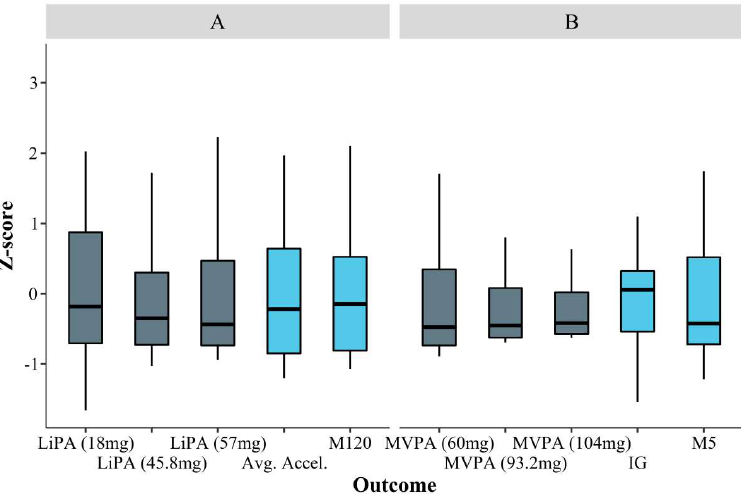
Figure 1. Box plots representing the distribution of Z-values for the conventional (grey) and cut-point-free (blue) physical activity accelerometer metrics, corresponding to: ( A ) physical activity volume and ( B ) intensity. LiPA = Light-intensity physical activity; Avg.Accel. = Average accelera- tion; M120 = Acceleration above which the most active 120 min of the day are accumulated. MVPA = Moderate-to-vigorous physical activity; IG = Intensity gradient; M5 = Acceleration above which the most active 5 min of the day are accumulated. Differences between dichotomous groups of health outcomes according to conven- tional and cut-point-free PA accelerometer metrics are presented in Table 4. Both cut-point-based and cut-point-free metrics presented significant associations with varia- bles such as the Barthel Index, MMSE or SPPB. Only the cut-point-free index M30 was significantly associated with 1-year survival. Descriptive results for the dichotomized groups presenting significant differences are displayed in Table 5. Centenarians who survived more than 1-year presented a me- dian of 36.8 mg [IQR: 19.8 mg] for M30, whereas those who died in the year following the measurements reported a median of 19.6 mg [IQR: 7.7 mg] for M30. Table 4. Differences in physical activity variables between dichotomous groups for different health outcomes. PA Variable Outcome